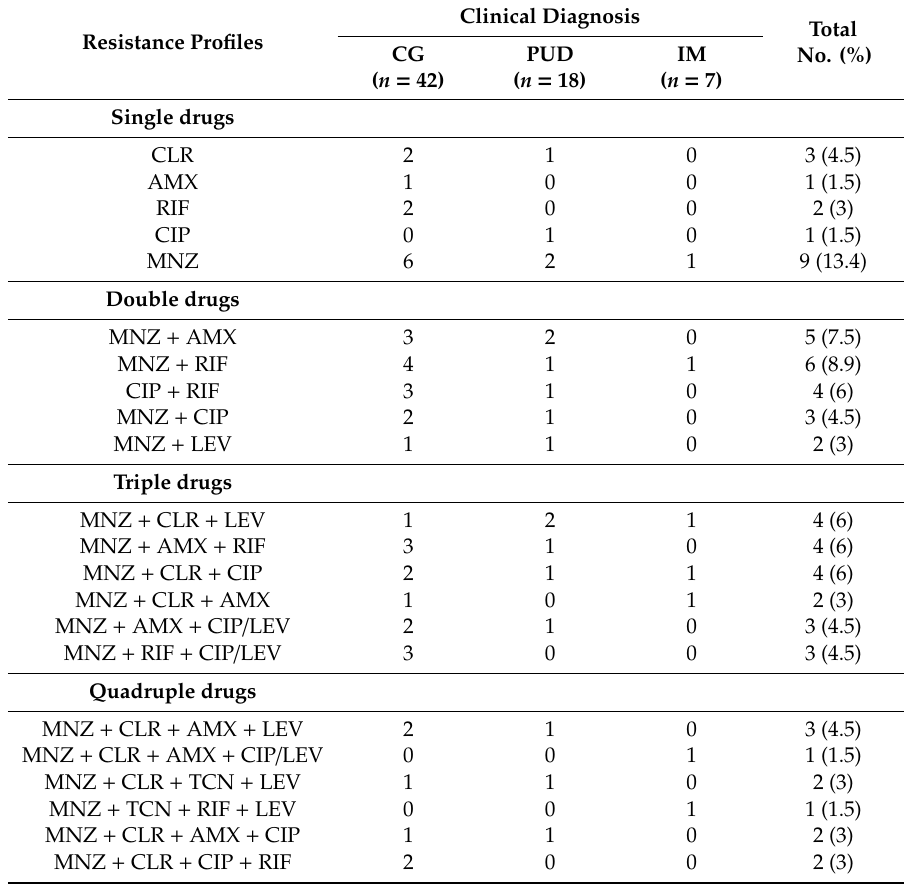
Table 4. Distribution of the multidrug resistance profiles in relation to clinical outcomes among H. pylori isolates used in this